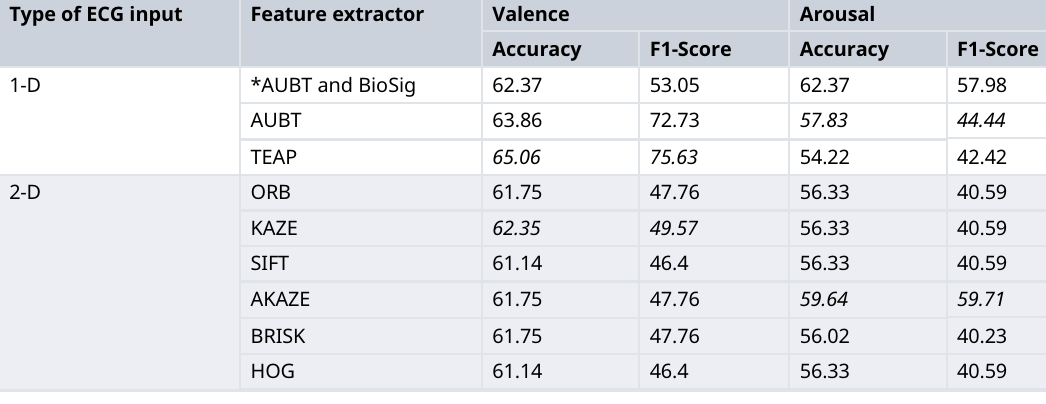
Table 6. Testing emotion classification accuracy and F1-score for 1-D and 2-D electrocardiogram (ECG).